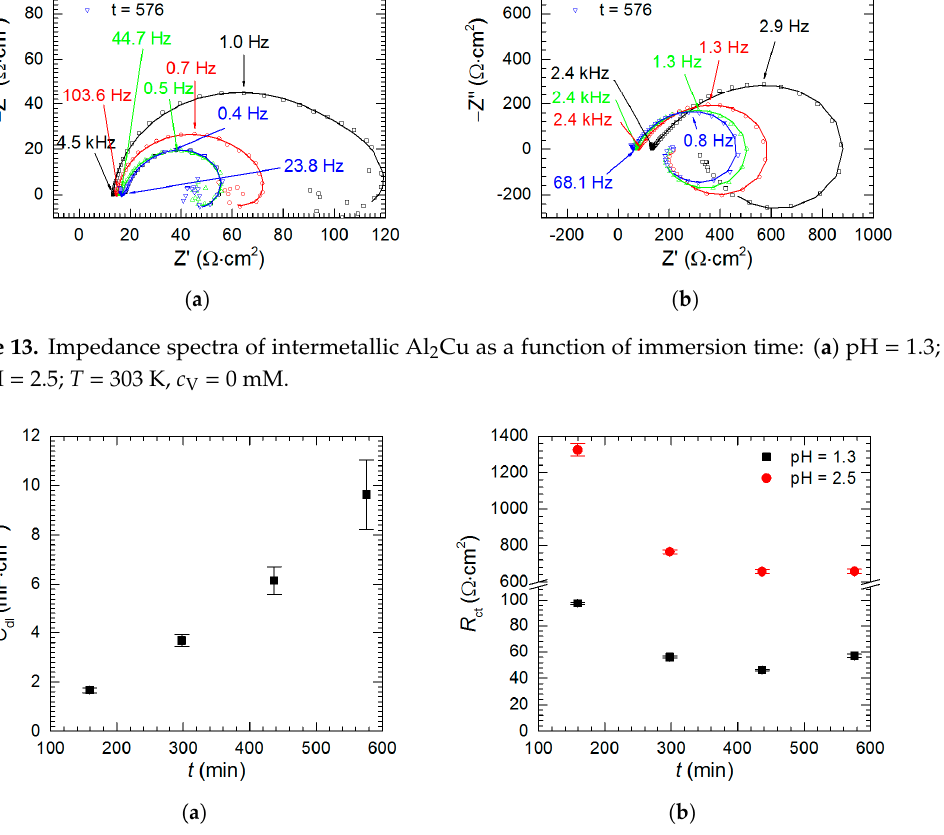
Figure 15. C dl · R ct product as a function of immersion time, pH = 1.3, c V = 0 mM, T = 303 K.